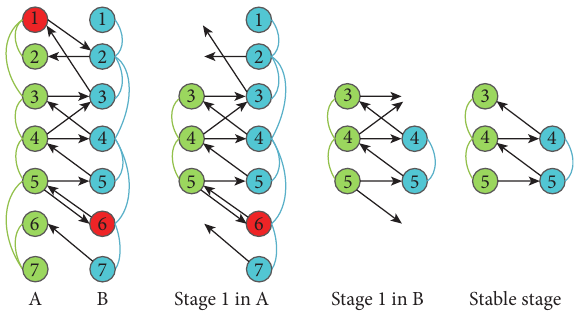
, a , and a . 11 12 13 , b , b , and b . In Stage 3, node 3 in 21 22 23 24 and b , also the LCC, 34 24